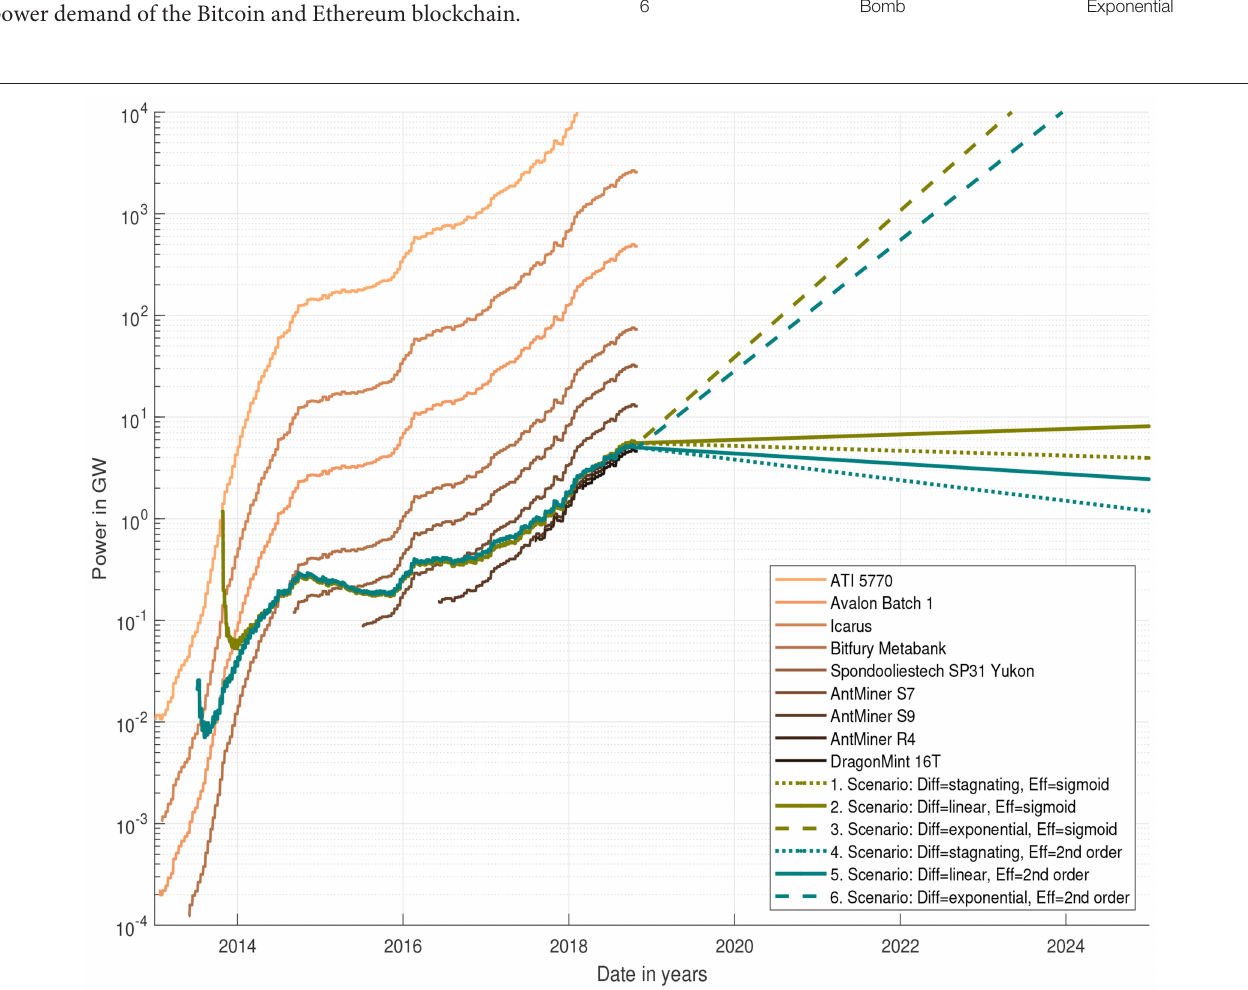
FIGURE 6 | Power demand for Bitcoin mining until October 2018 if only one hardware was used throughout the network and scenarios 1–6 until 2025 for the future development of the power demand. Bitcoin hardware data from Zade and Myklebost (2018).